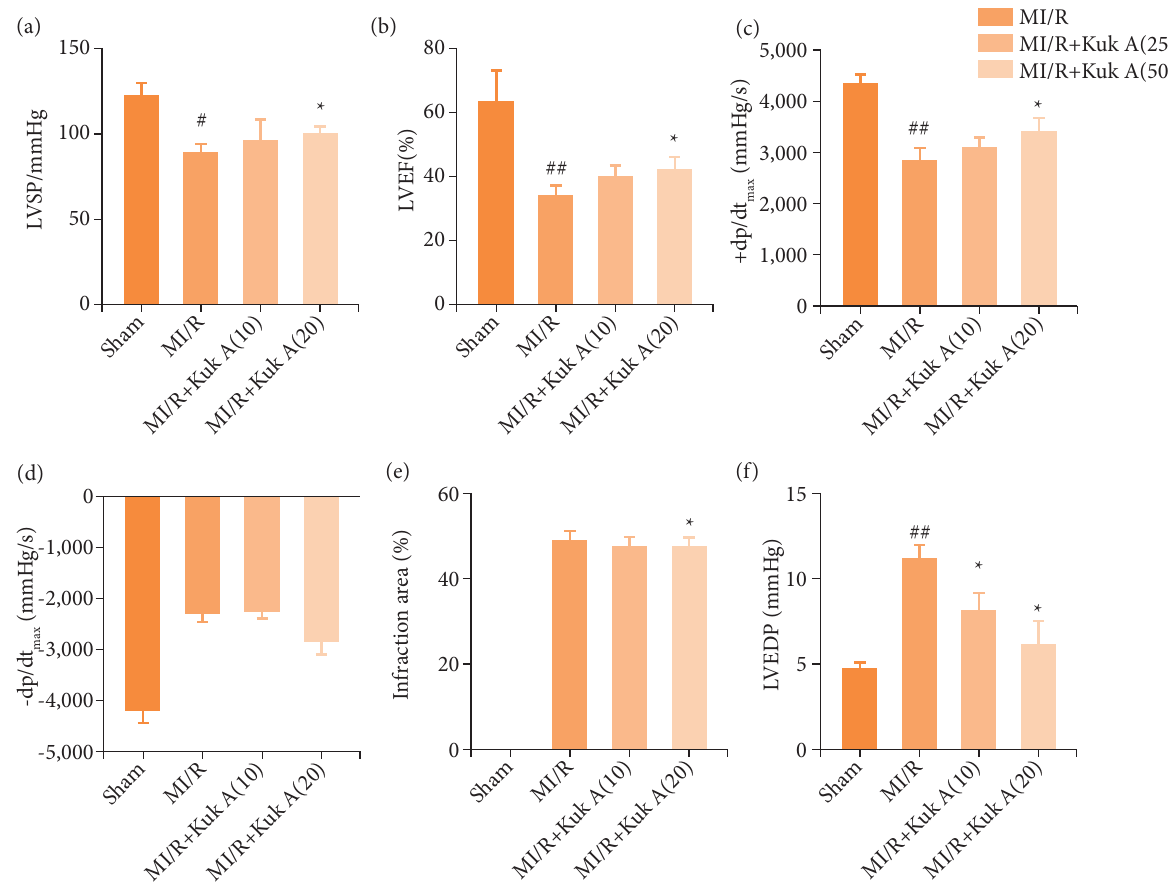
Figure 1 - Effects of KukA on cardiac hemodynamic changes and infarction area after MI/R treatment in rats. Effect of KukA on oxidative stress and myocardial cell apoptosis after ischemia/reperfusion treatment in